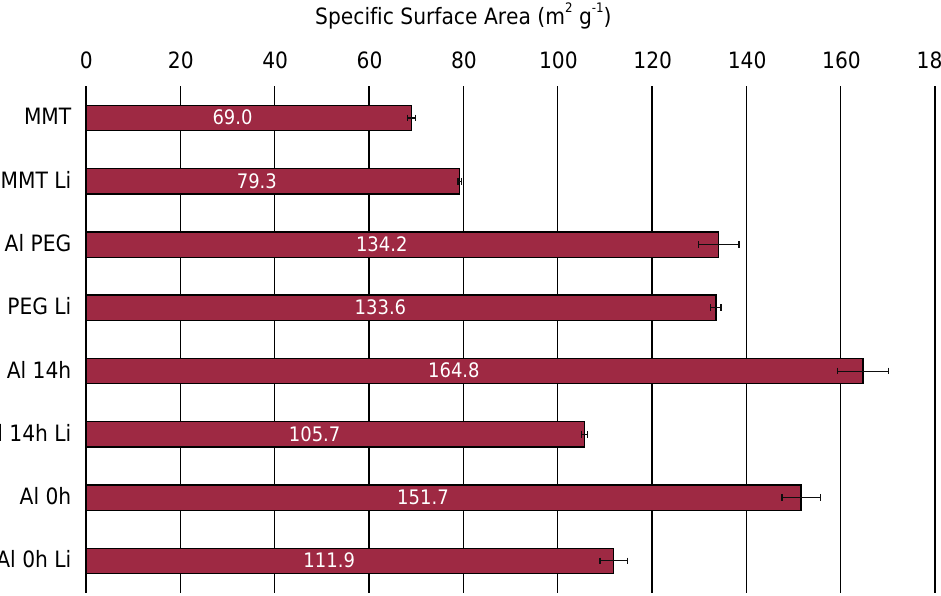
Figure 9. Specific surface area of natural MMT, Al-pillared, and saturated with Li samples. The dashes in the bars mean the standard deviation of the